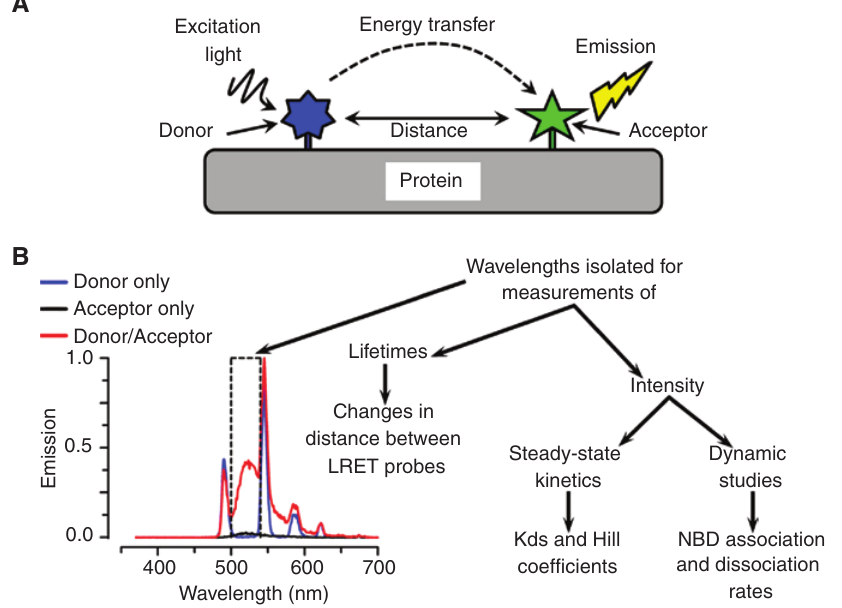
Figure 3: (A) Schematic representation of energy transfer between donor and acceptor probes. The process of energy transfer is highly dependent on the donor-acceptor distance. Energy transfer results in decreased donor emission, increased acceptor emission and shorter lifetime of the excited state of the donor molecules that participate in energy transfer. In LRET, the latter is essentially identical to the long lifetime emission of the fluorophore acceptor (sensitized emission). (B) Emission spectra of LRET donor (Tb-only) and donor-acceptor (Tb- fluorescein). When the emission is measured in gated mode, acceptor emission (fluorescein in this case) due to direct excitation is very low (acceptor only, black trace). This is expected from the short duration of the excitation pulse and the short lifetime of the fluorescein excited state ( ~ 3 ns). Tb 3 + emits in sharp peaks with interposed dark regions (donor only, blue trace), and therefore a band-pass emission filter easily isolates the acceptor sensitized-emission (emission with long lifetime) from the luminescence of the lanthanide complex. The emis- sion peak at ~ 520 nm (red trace) is the sensitized emission from fluorescein (long-lifetime acceptor emission arising from energy transfer), and exhibits microsecond lifetimes. Intensity and lifetime measurements that we usually perform are listed. Modified from Bao et al.